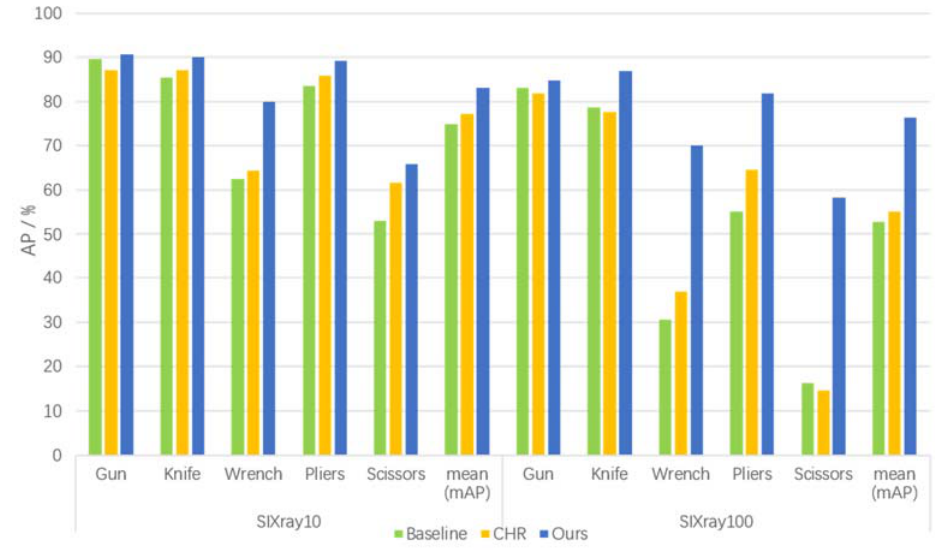
Figure 4. The performance gained by the proposed method shows enormous variation between